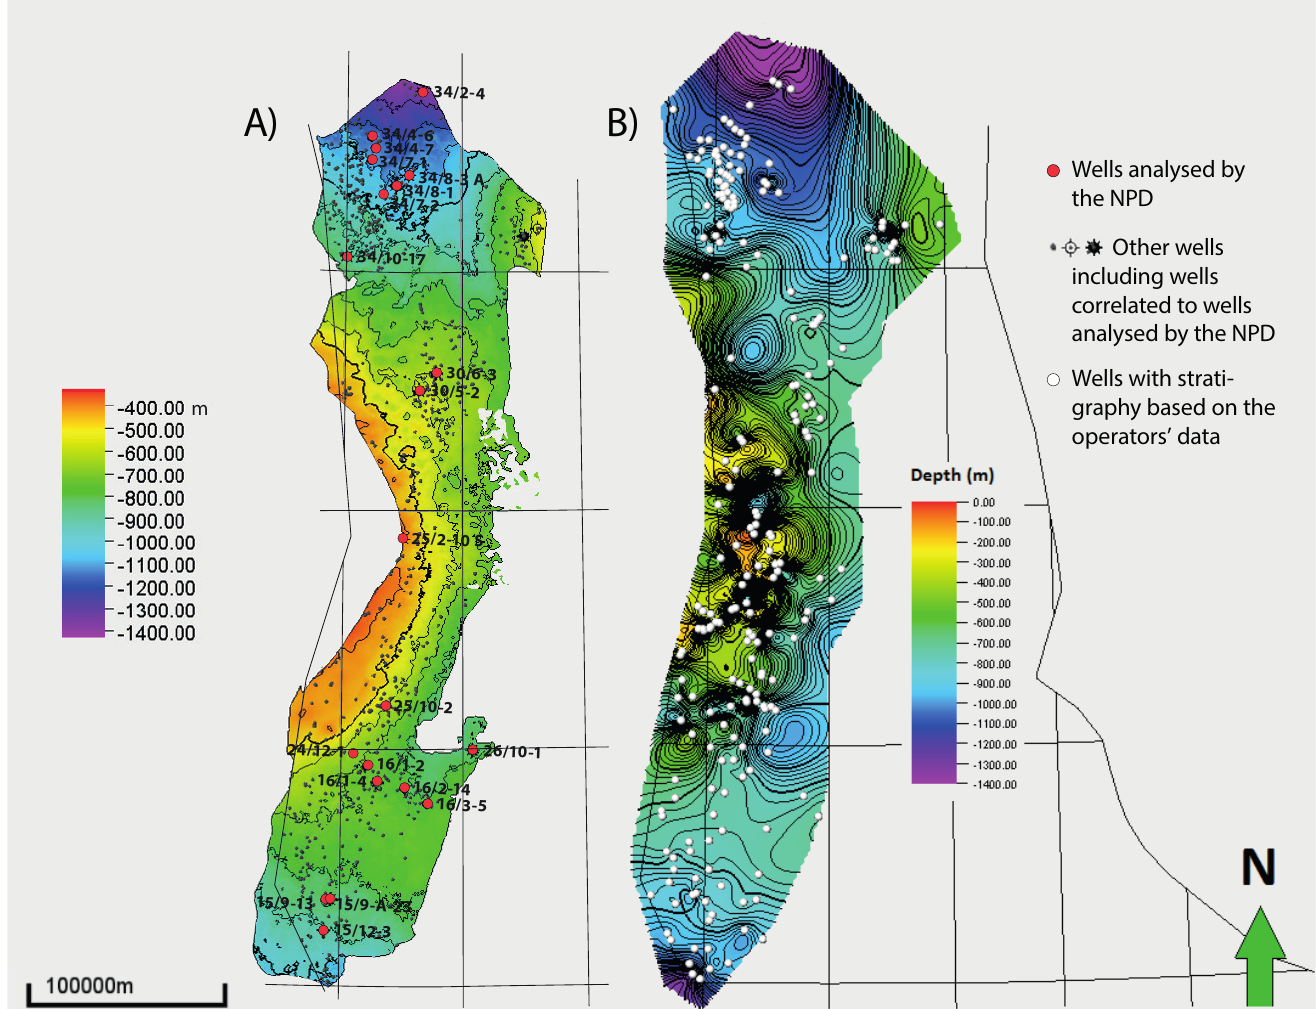
Figure 3. Figure showing (A) a compilation of the depth to the top of the Utsira Group based on NPD’s own well data with (B) a map based on well-data obtained by the oil companies’ contracted consultants (modified after Eidvin & Rundberg, 2016b;